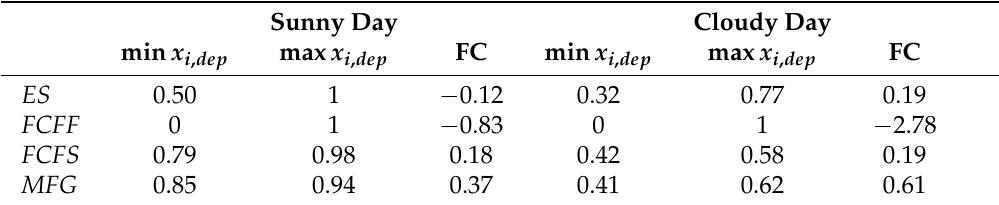
Table 3. Comparison of fairness coefficient and departing SOCs (min x i , arr = 0, max x i , arr = 0.45) for a fluctuating population of 400 BEVs.